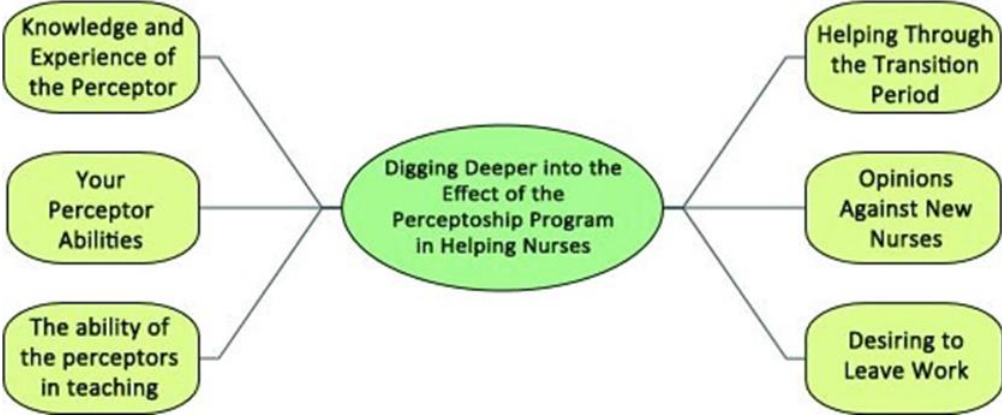
Fig. 6. Themes and sub-themes the influence of the preceptorship